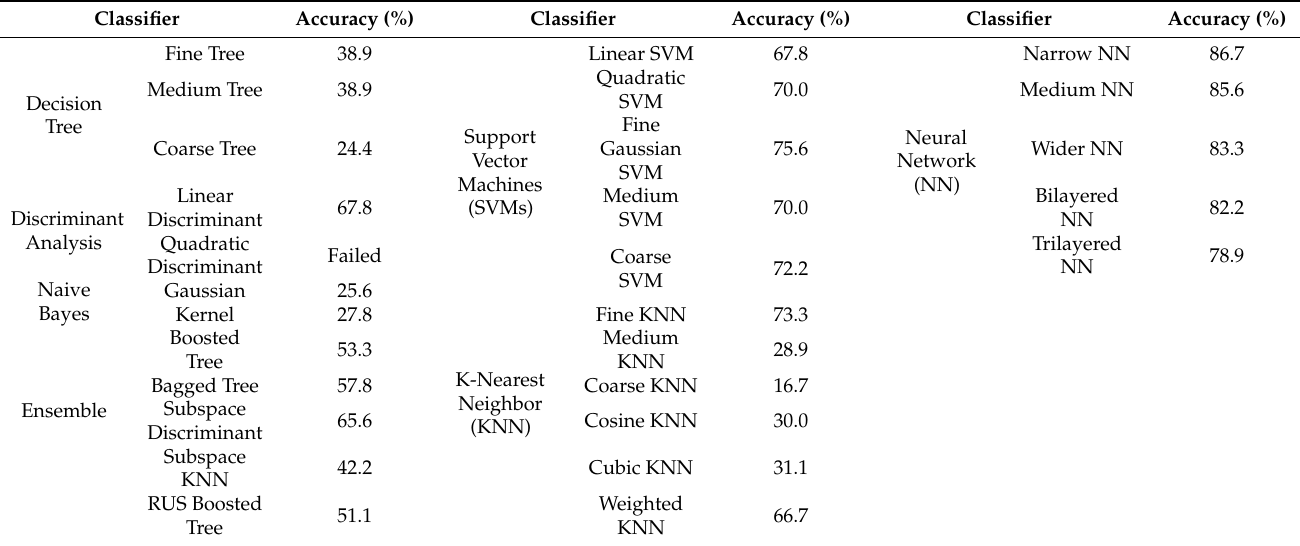
Table 1. The accuracy of different machines learning algorithms in Classification Learner App.